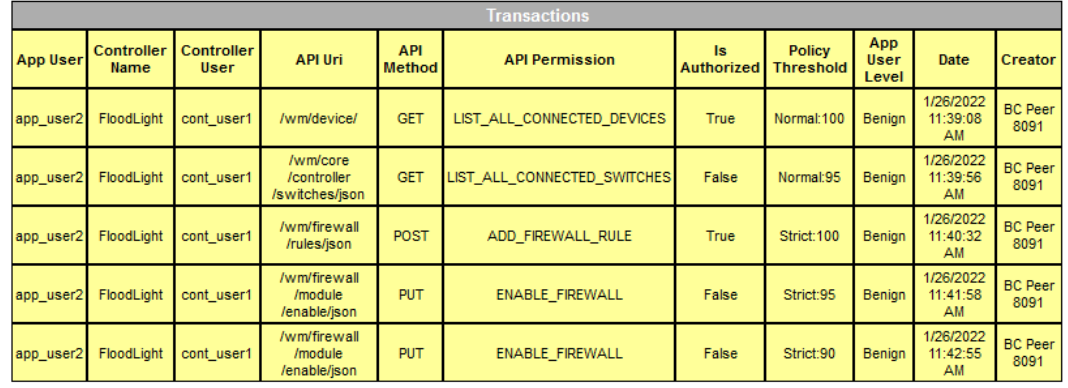
Figure 7. Transaction